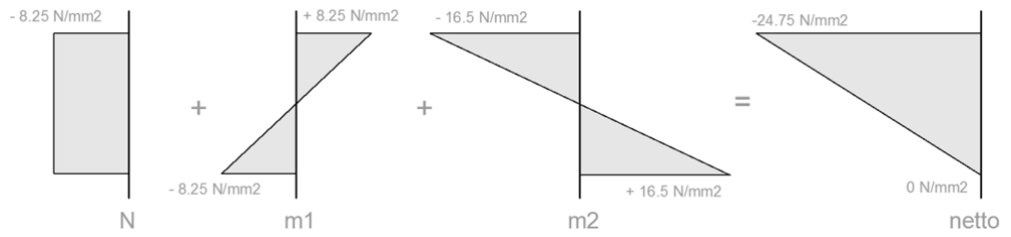
Fig. 8 Stress diagrams for the post tensioned